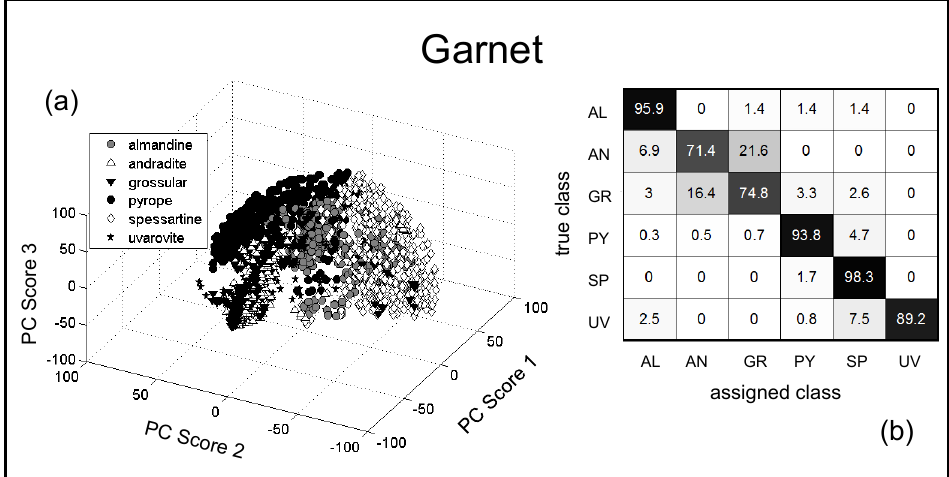
Figure 4. Principal component analysis (PCA) score plot ( a ) and partial least squares discriminant analysis (PLSDA) classification matrix ( b ) for the analysis of the common garnet groups using a SciApS Z-500 handheld LIBS analyzer (data from Reference [79]). AL = almandine (Fe 3 Al 2 Si 3 O 12 ), AN = andradite (Ca 3 Fe 2 Si 3 O 12 ), GR = grossular (Ca 3 Al 2 Si 3 O 12 ), PY = pyrope (Mg 3 Al 2 Si 3 O 12 ), SP = spessartine (Mn 3 Al 2 Si 3 O 12 ), and UV = uvarovite (Ca 3 Cr 2 Si 3 O 12